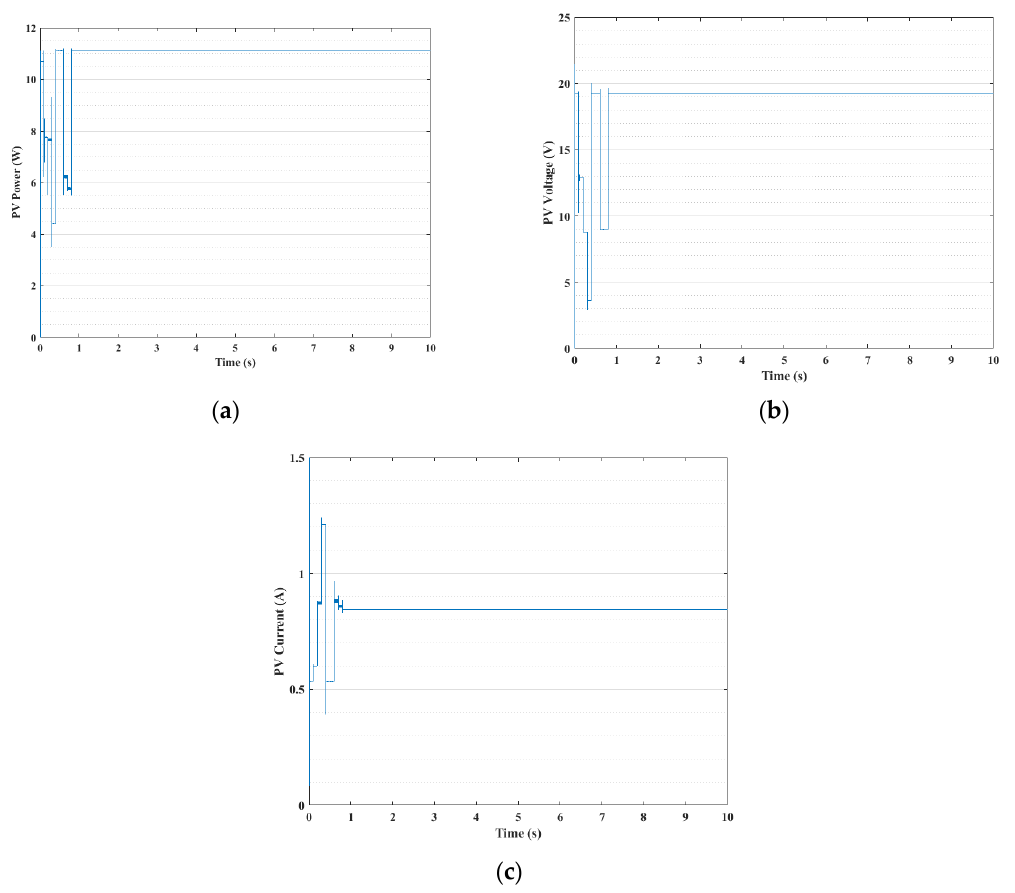
Figure 14. Modified LFO at PSC2. ( a ) power ( b ) voltage ( c ) current. PSC 3 is created by non-uniform irradiances on the PV panels as shown in Table 4. The modified LFO is tested. Again, as can be seen, the modified LFO has successfully